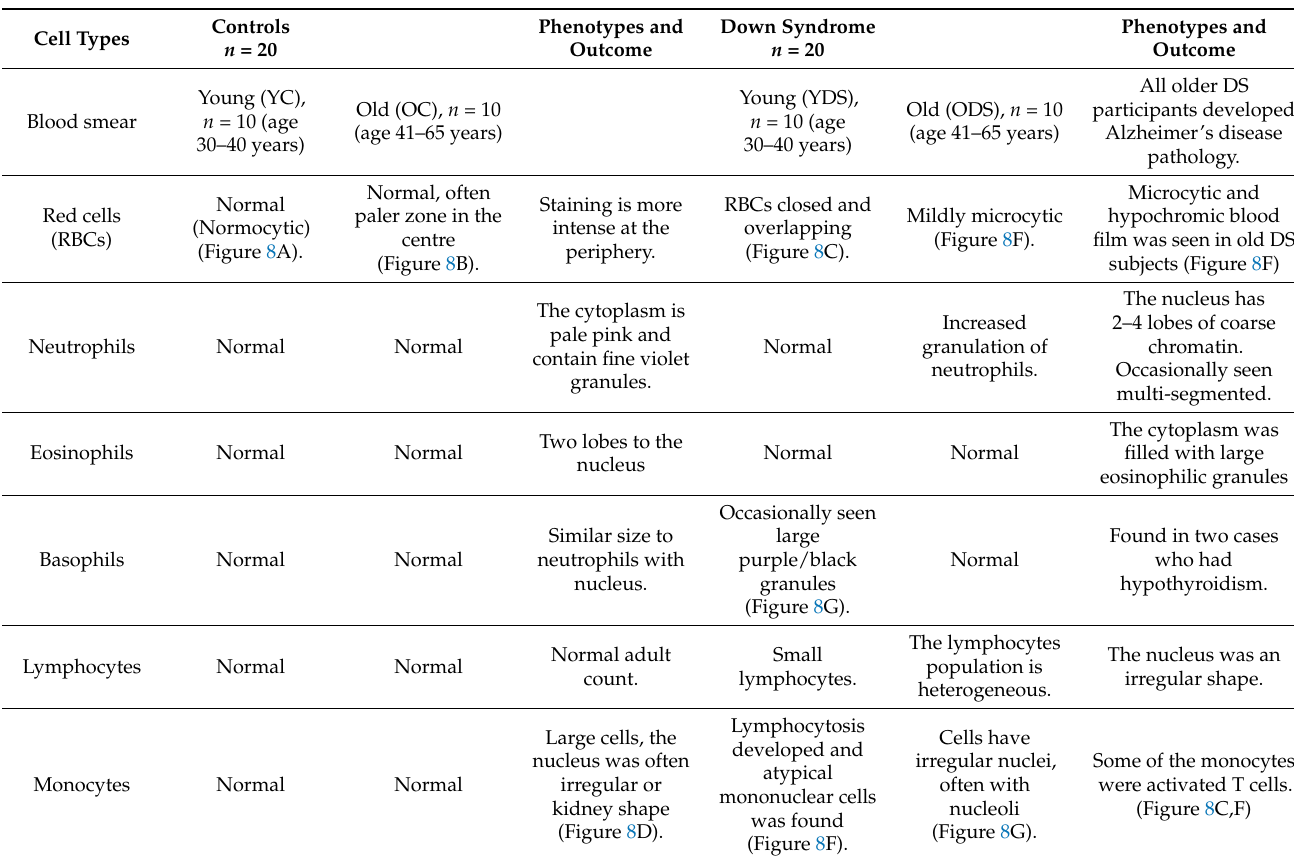
Table 3. Characterisation of blood smears of Down syndrome and normal control